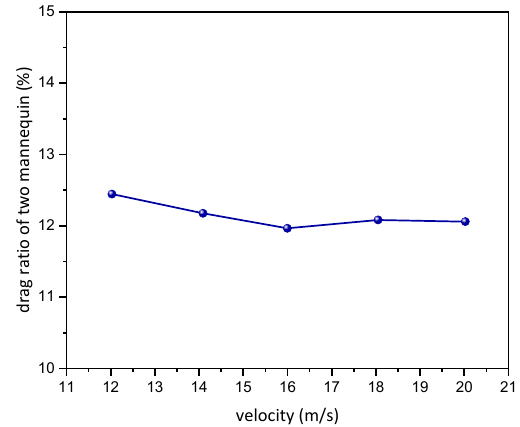
Figure 16. The drag ratio of the simplified mannequin to the complete one.